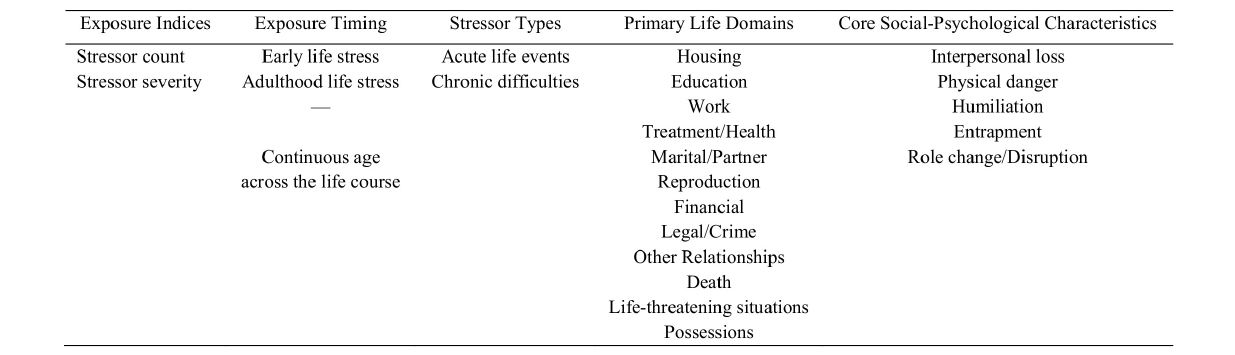
FIGURE 1 | Dimensions of life stress assessed by the Stress and Adversity Inventory for Adults (Adult